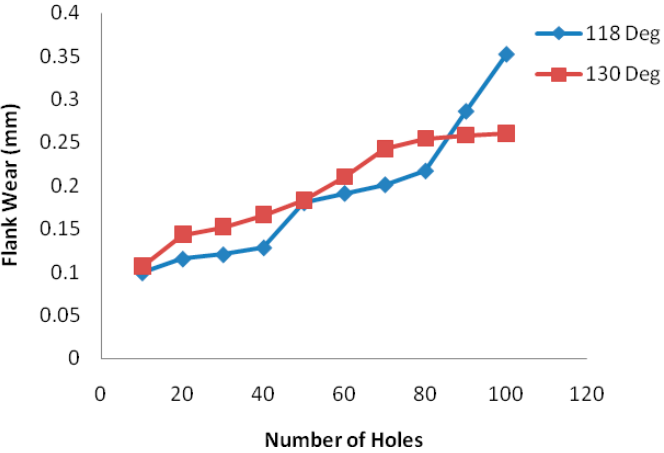
Figure 7. Effect of flank wear on point angle [29].